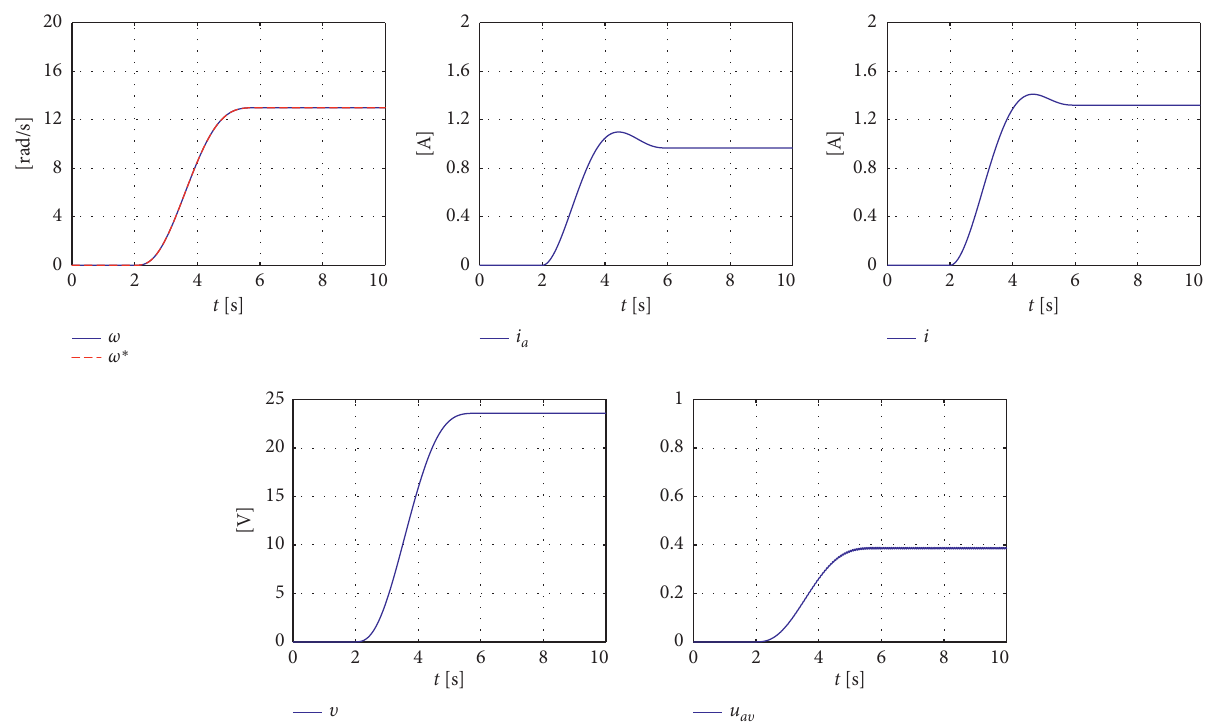
Figure 7: Dynamic behavior of the DC/DC Buck converter-DC motor system when E ( t ) is given by equation (18) and when the abrupt changes (equation (22)) are introduced in C